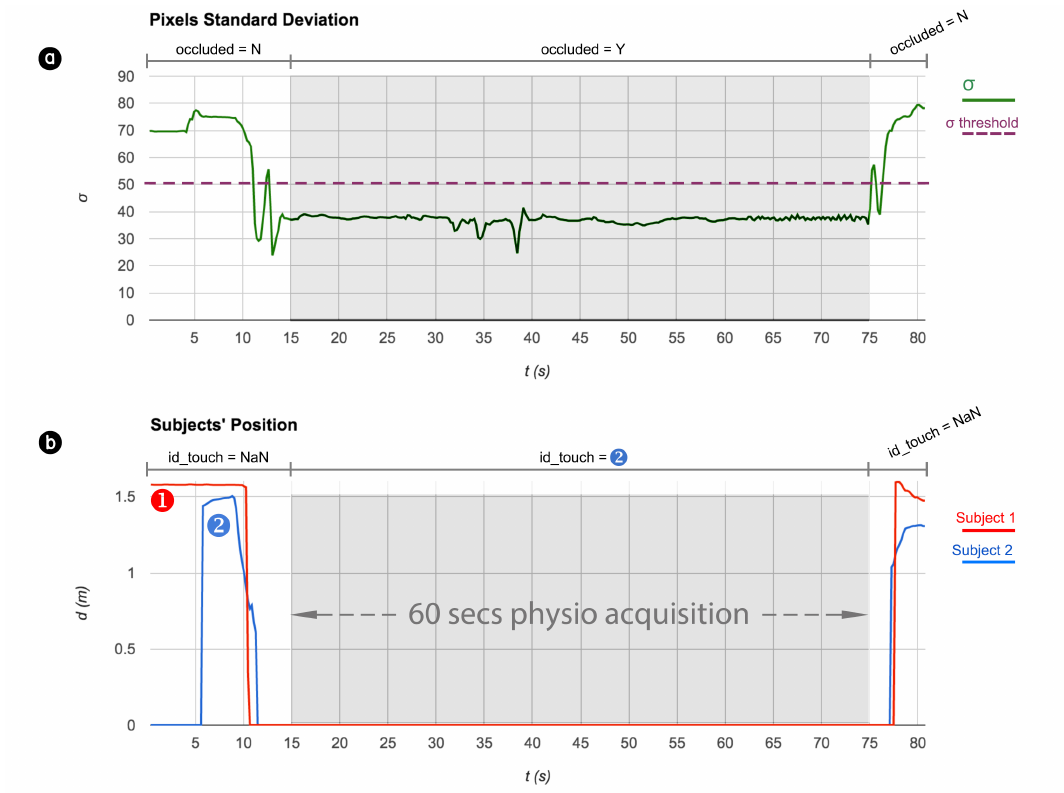
Figure 10. IDTm (ID Tracking Module) Validation Test; ( a ) Pixels Standard Deviation of the elaborated image; ( b ) position of the subjects in terms distance